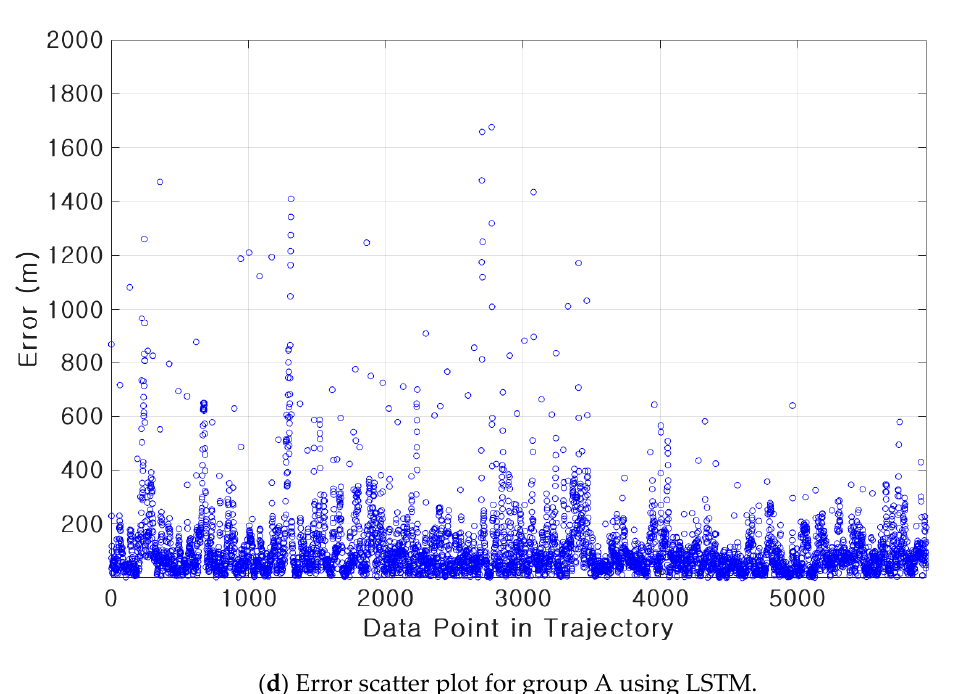
( d ) Error scatter plot for group A using LSTM.